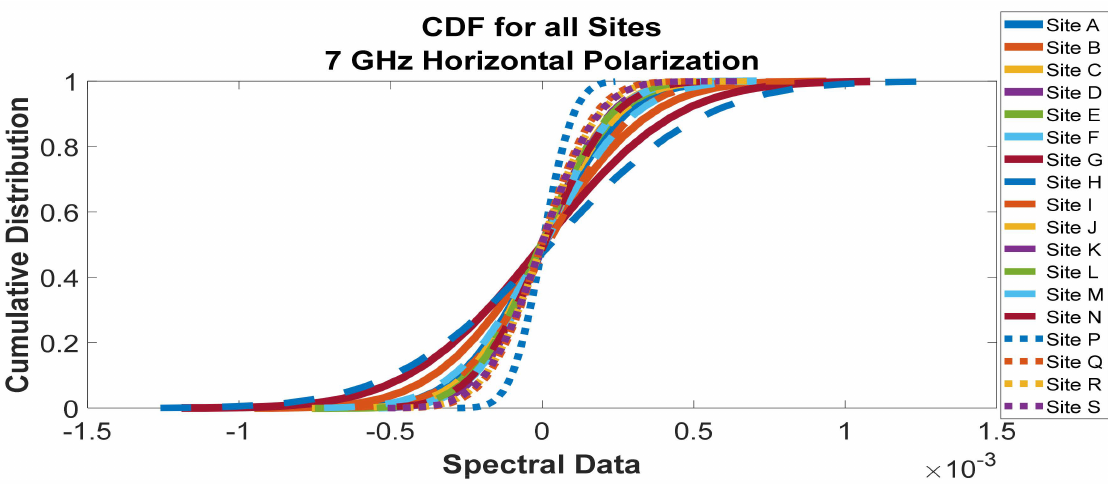
Figure 37. Cumulative distribution functions of frequency scan for all sites at 7 GHz horizontal